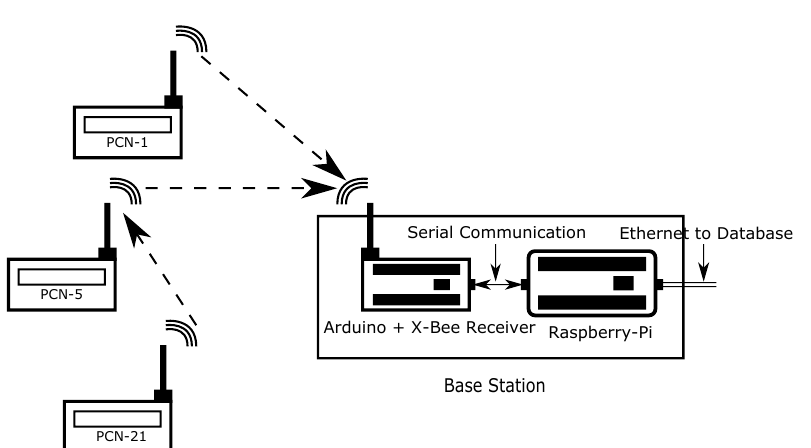
Figure 3. A schematic of the data transfer chain over the PCIEM